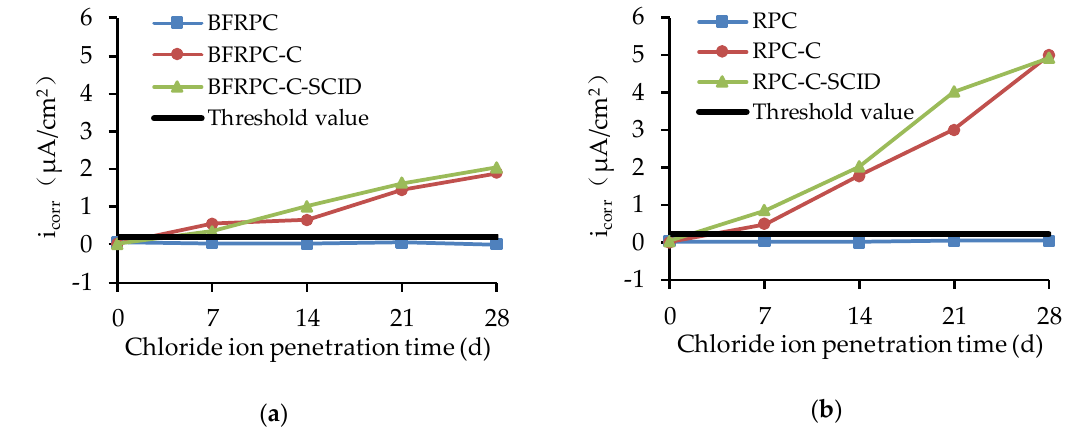
Figure 9. Self-corrosive current density (i corr ) for: ( a ) BFRPC specimens; ( b ) RPC specimens.